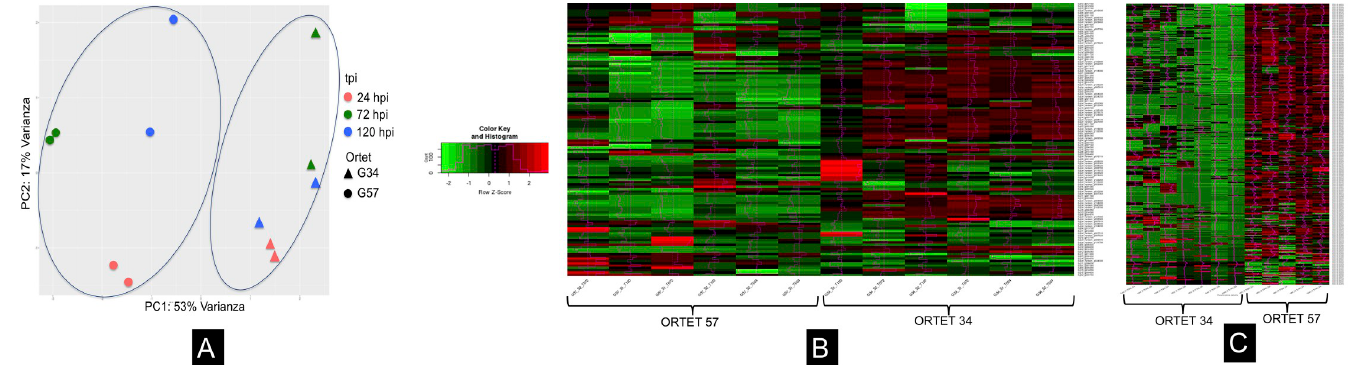
Fig 1. Differential expression profile for pathosystem oil palm clon- P . palmivora . A: Component Principal Analysis (PCA). B: Heatmap for oil palm clones C: Heatmap for P . palmivora expressing during infection process. Ortet 57: susceptible. Ortet 34: resistant.